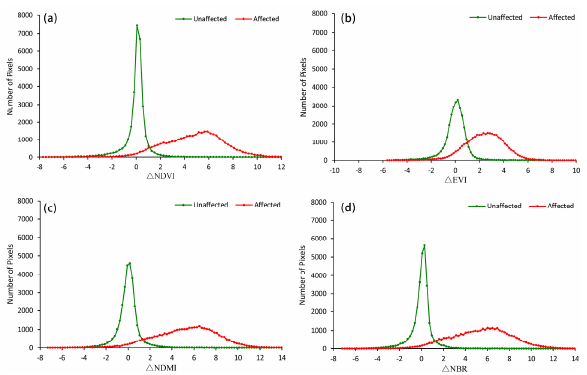
Figure 6. Normalized variation histograms of remote sensing indices Table 1. Mean normalized variations of the affected